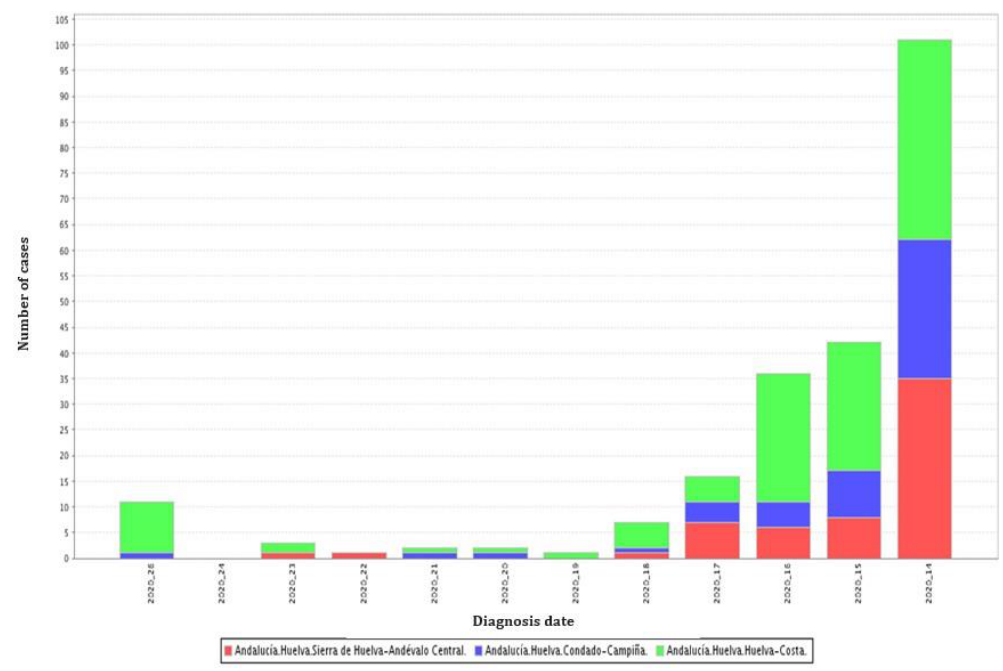
Figure 1. Cases of COVID-19 in the zones of the province of Huelva grouped by weeks